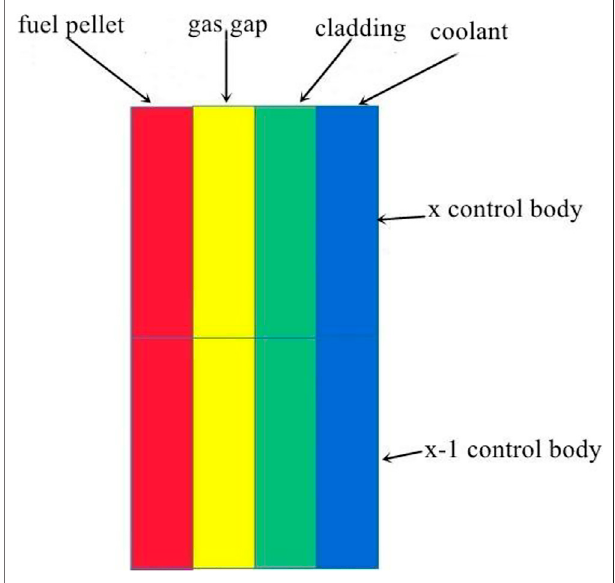
FIGURE 1 | Fuel rod heat conduction